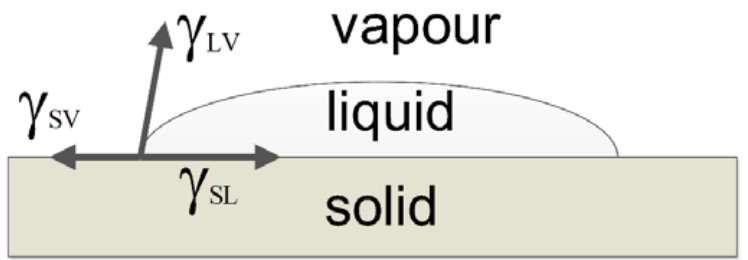
Figure 12. Equilibrium of forces acting at solid–liquid–gas interfaces.